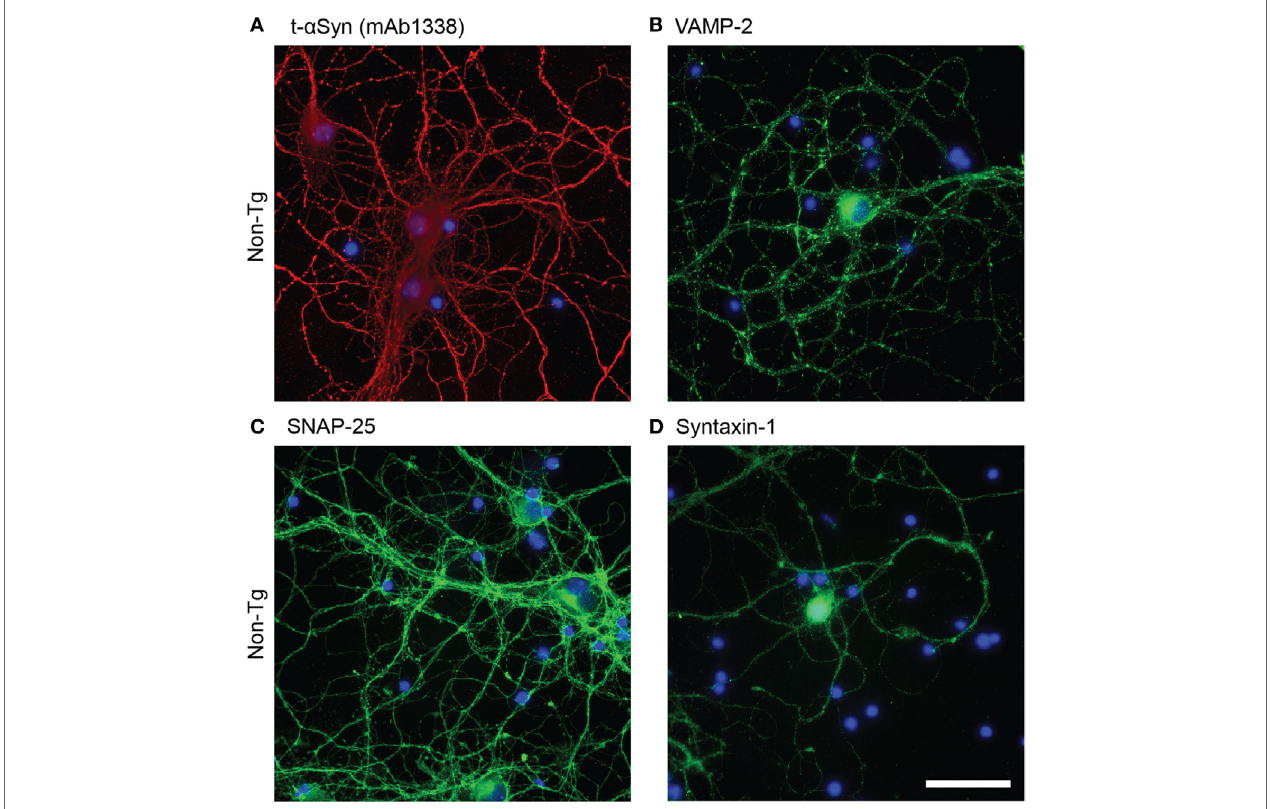
FigUre 1 | Representative images of immunofluorescence staining of non-tg cortical primary neurons (12 DIV) using antibodies against alpha-synuclein ( α Syn) [mAb1338, red, (a) ], VAMP-2 [(green), (B) ], SNAP-25 [(green), (c) ], and syntaxin-1 [(green), (D) ]. DAPI in blue. Scale bar 50 µm.